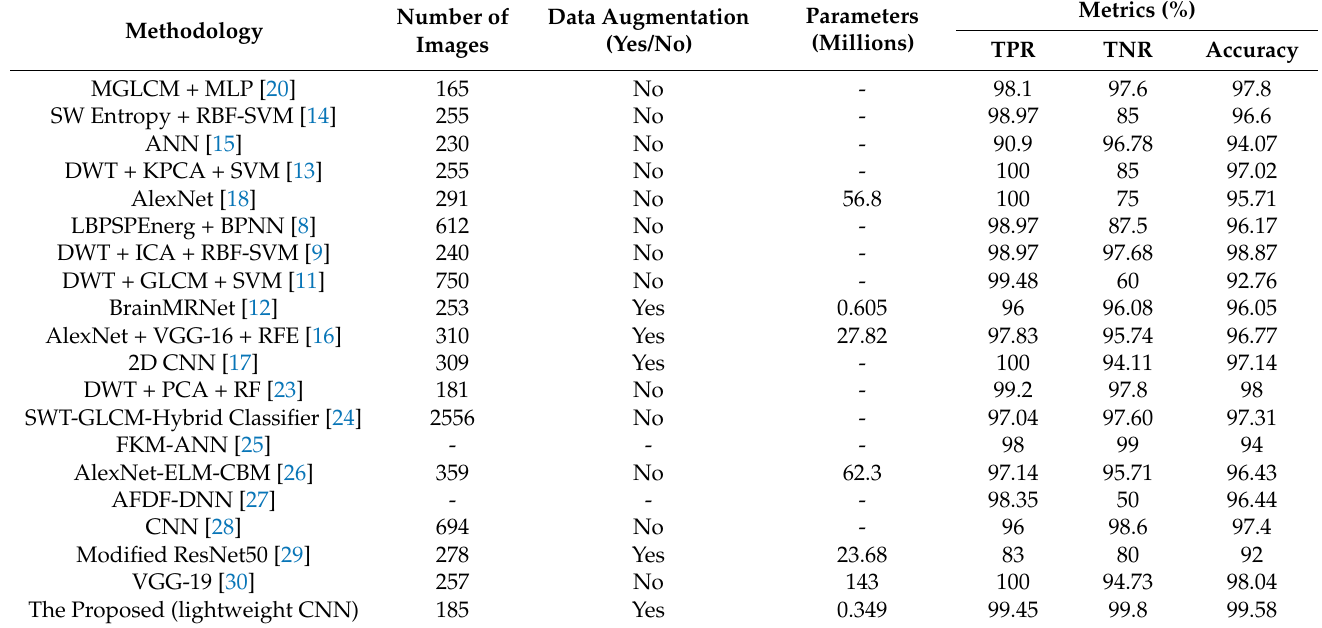
Table 12. Classification performance of the suggested method and existing works.